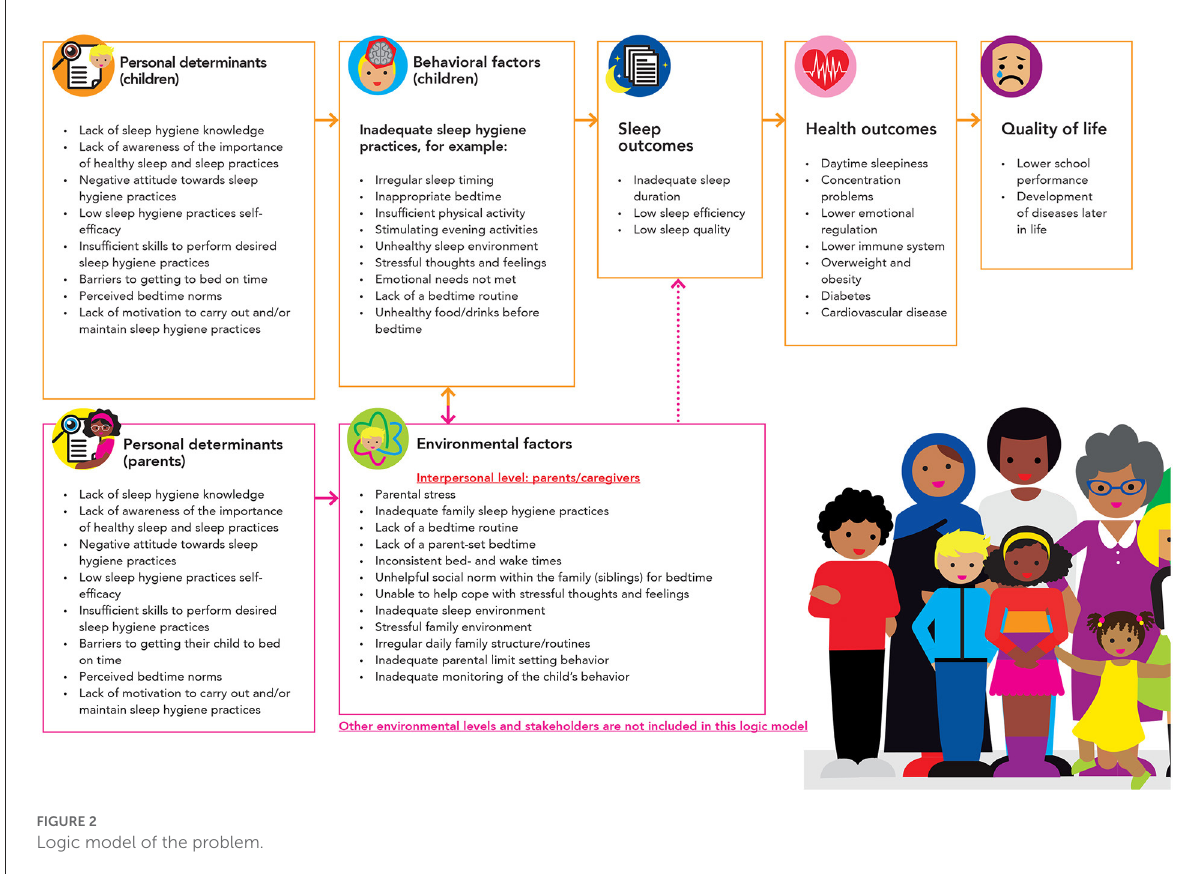
FIGURE2 Logic model of the problem.